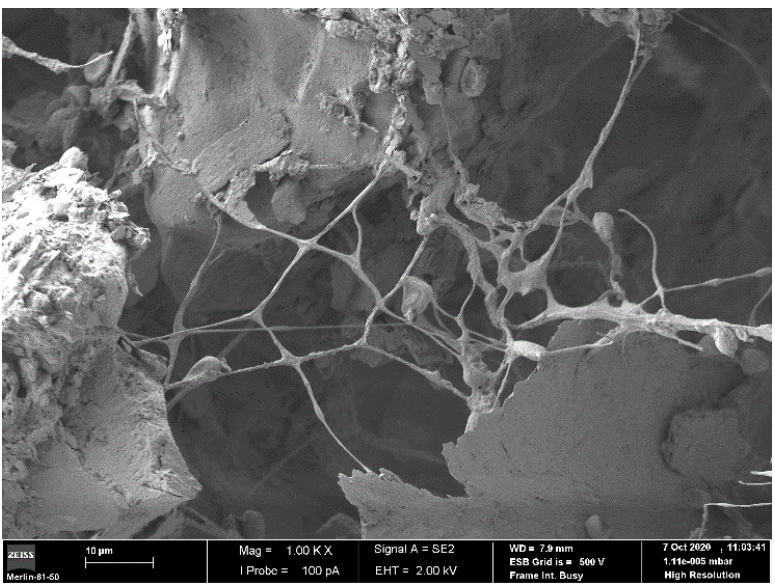
Figure 1. SEM image of the structure of a sandy soil stabilized with xanthan gum [22]. Previously, a thin layer of gold coating was deposited on the sample by sputtering. SEM tests were performed in accordance with Pansu and Gautheyrou [23].